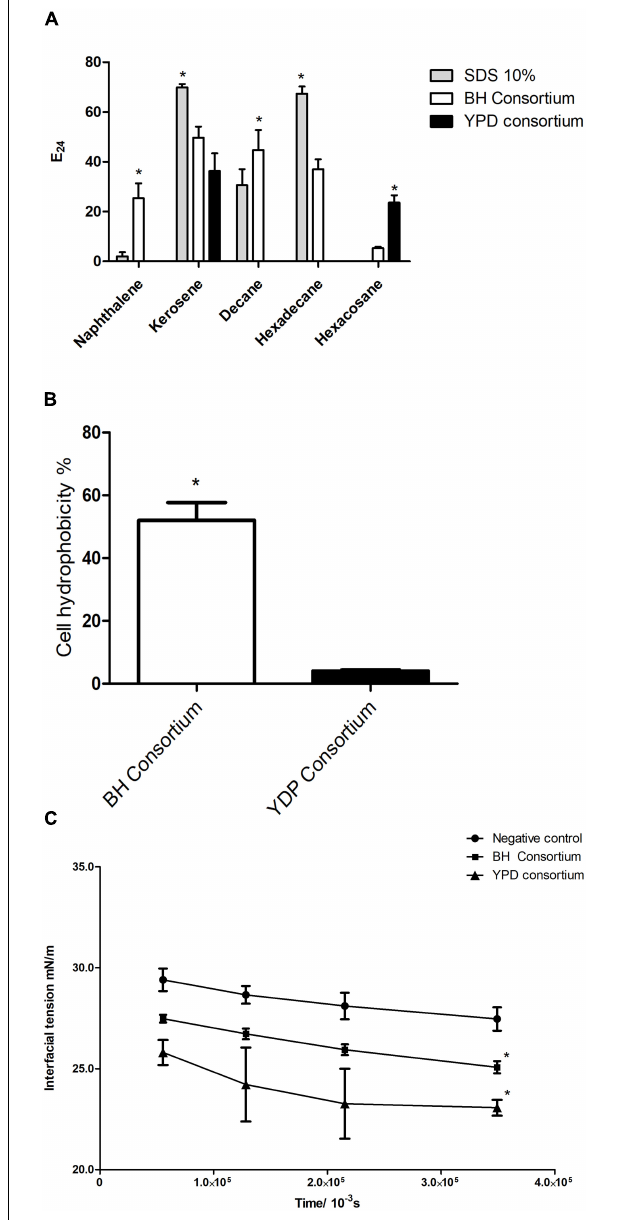
FIGURE 6 | Production of biosurfactants by consortia. (A) Emulsification indexes (E24%) for BH and YPD consortia in different hydrocarbons (naphthalene, kerosene, decane, hexadecane, and hexacosane). The statistical significance was analyzed by a two-way ANOVA (* p < 0.05). (B) Cell hydrophobicity in YPD and BH consortia. These were analyzed using a t -test (* p < 0.05). (C) Evaluation of the interfacial tension in relation to the time of release of the oil droplet in contact with the supernatant of the BH and YPD consortia. This result was analyzed by a two-way ANOVA (* p < 0.05 compared to the